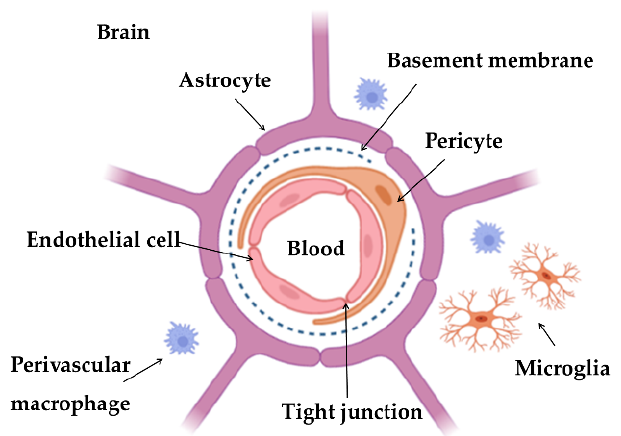
Figure 2. Illustration of BBB constitution.